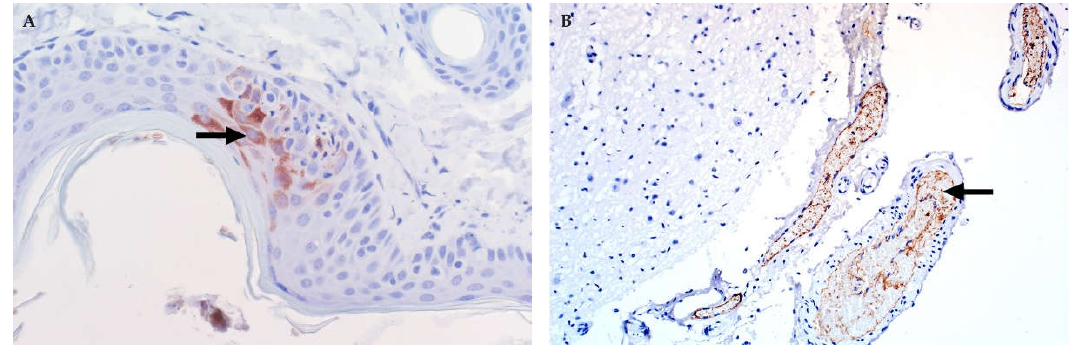
Figure 14. Skin and brain of RVFV-infected sheep (NovaRed IHC as detailed in Figure 5). ( A ) Immunolabelling in the epidermis (arrow) of an adult sheep, mag ×400. ( B ) Viral antigen in vascular endothelial cells and cellular debris in small blood vessels in the meninges (arrow) of a young lamb, mag 200×.